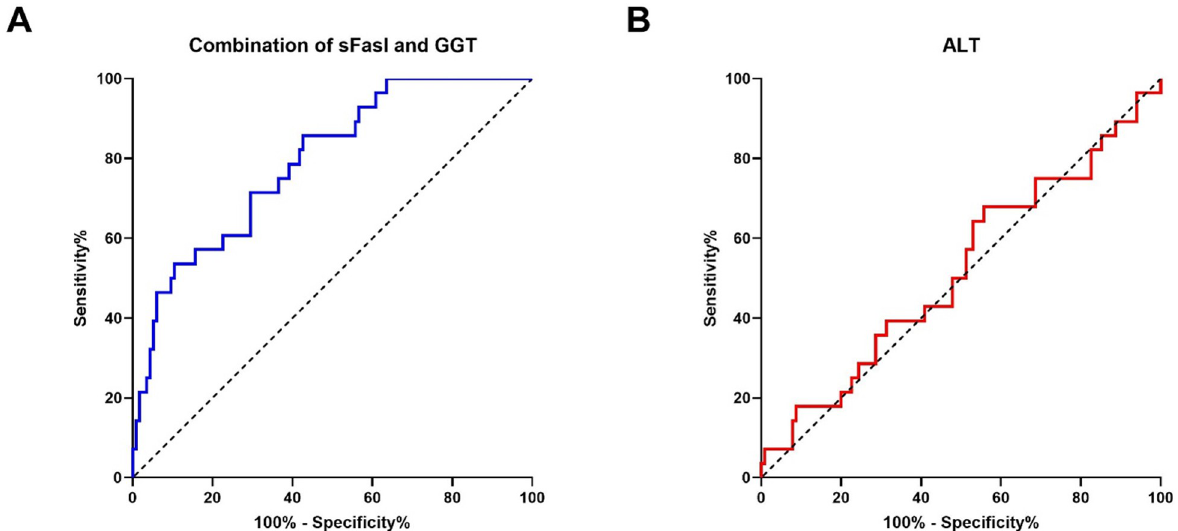
Fig 2. Area under the receiver operating characteristics (AUROC). (A) the marker combination sFasL plus GGT predicting the risk for AD during follow-up and (B) ROC curve for baseline ALT levels without predictive capacity for